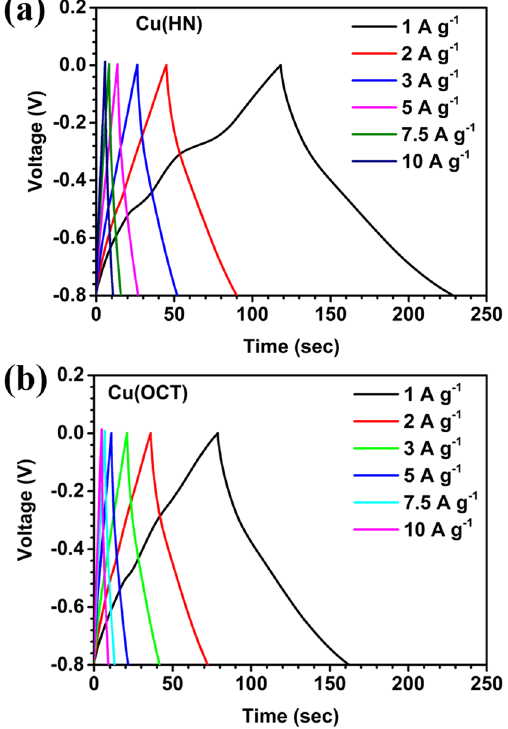
Figure 6. CD curves of ( a ) Cu-HN and ( b ) Cu-OCT at different current